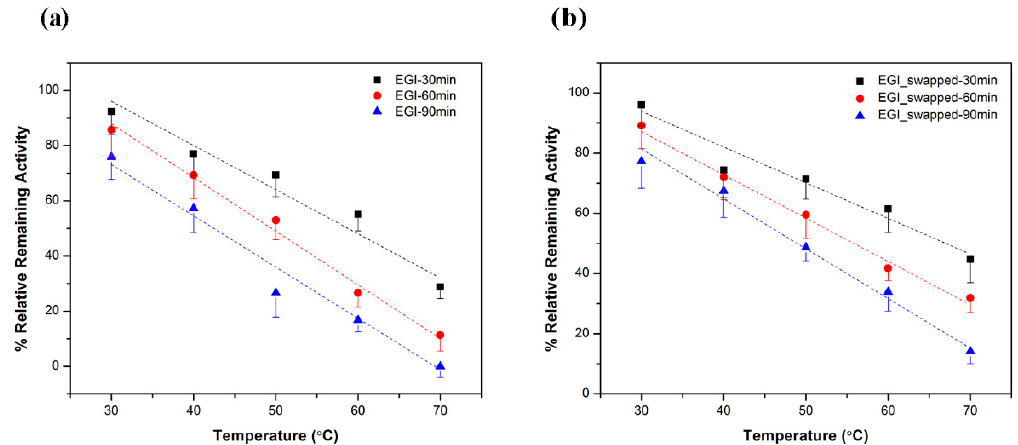
Figure 4. The thermal stability results; ( a ) EGI and ( b ) EGI_swapped enzymes toward CMC. The remaining relative activities of enzymes toward 0.5% w/v CMC were measured after incubating enzymes at different temperatures (30–70 ◦ C/10 ◦ C) for 30, 60 and 90 minutes. For each EGI and EGI_swapped enzymes, the enzymatic activities at 30 ◦ C without any thermal incubation were set to 100% in order to calculate the rest. Data are express as mean ± SD, n =